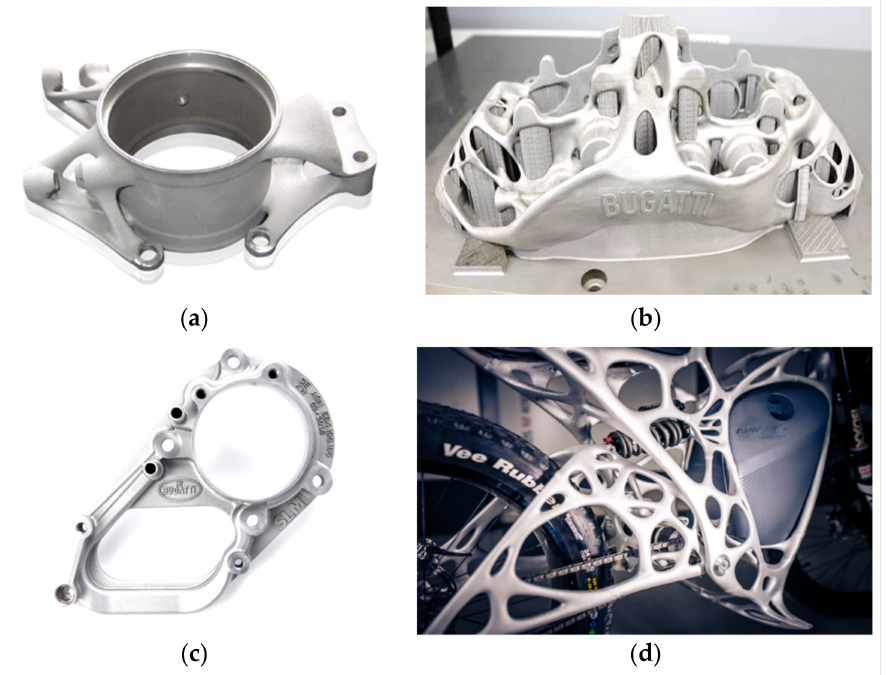
Figure 4. Automotive additive manufactured components: ( a ) Steering knuckle [68], ( b ) Bugatti brake caliper [72], ( c ) Bugatti topology optimised bracket [72], and ( d ) Lightweight structure made in Scalmalloy aluminum [74].